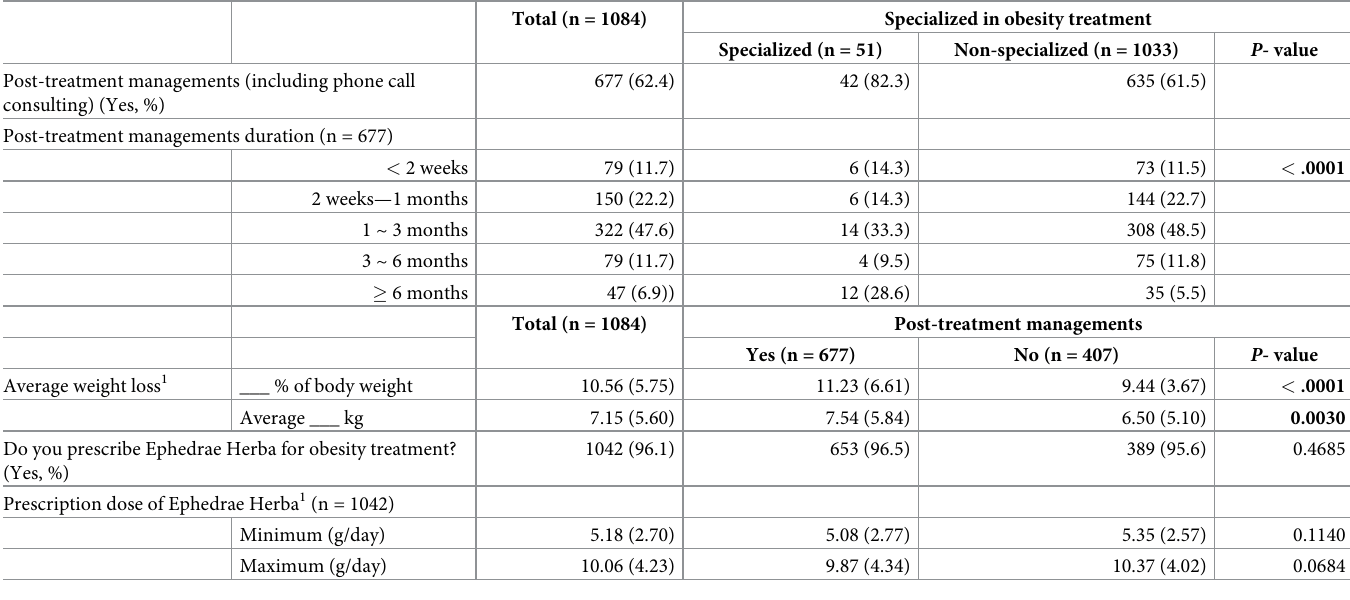
Table 5. Post-treatment management for obesity